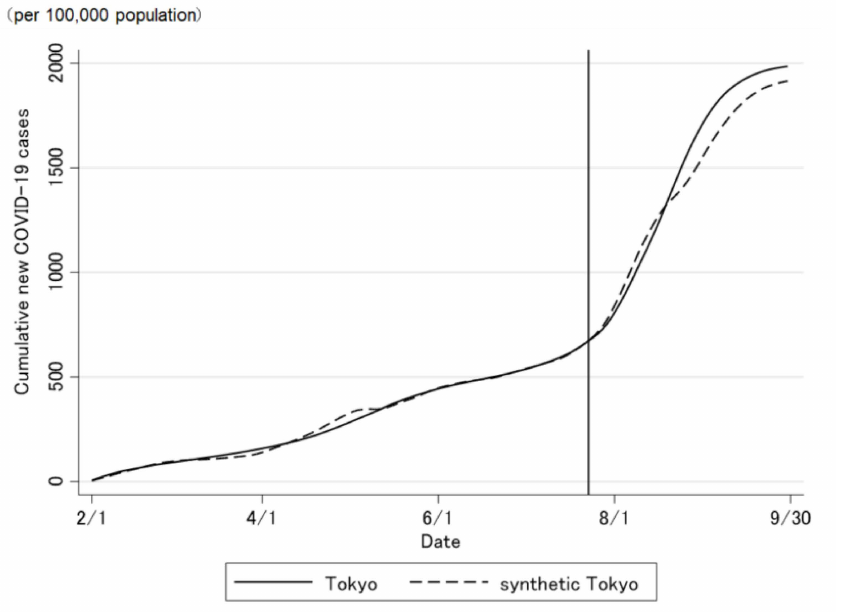
Figure 8. Trends of the cumulative daily number of newly confirmed COVID-19 cases in Tokyo and synthetic Tokyo, determined using regression weights.